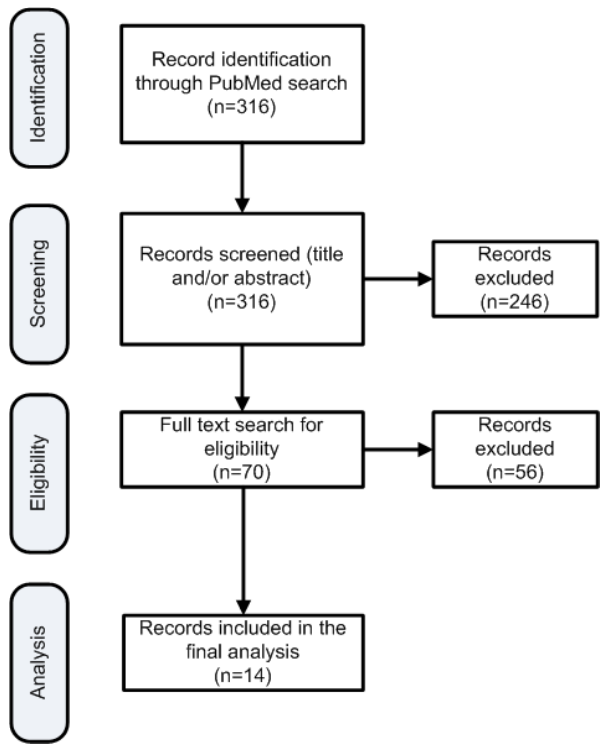
Figure 1. Flowchart of the search strategy to identify publications for reference PFS estimation.